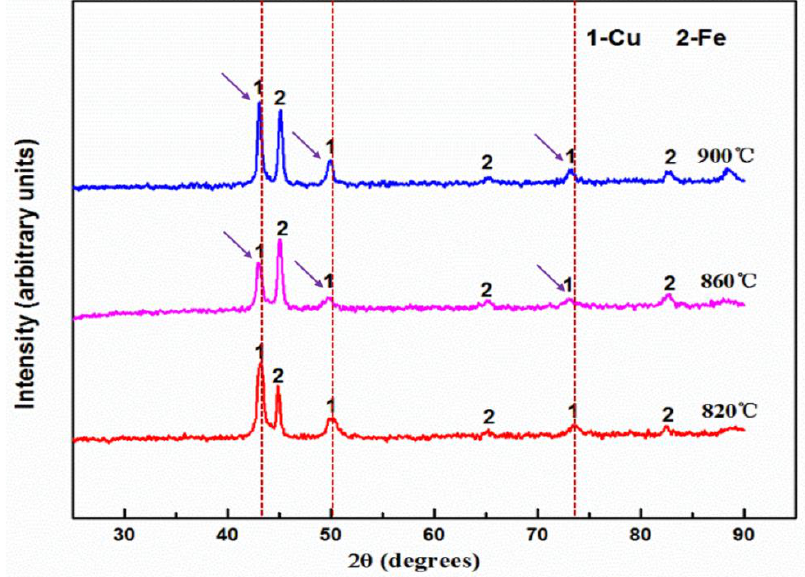
Figure 7. X-ray diffraction (XRD) patterns of samples by microwave sintering at different temperatures.